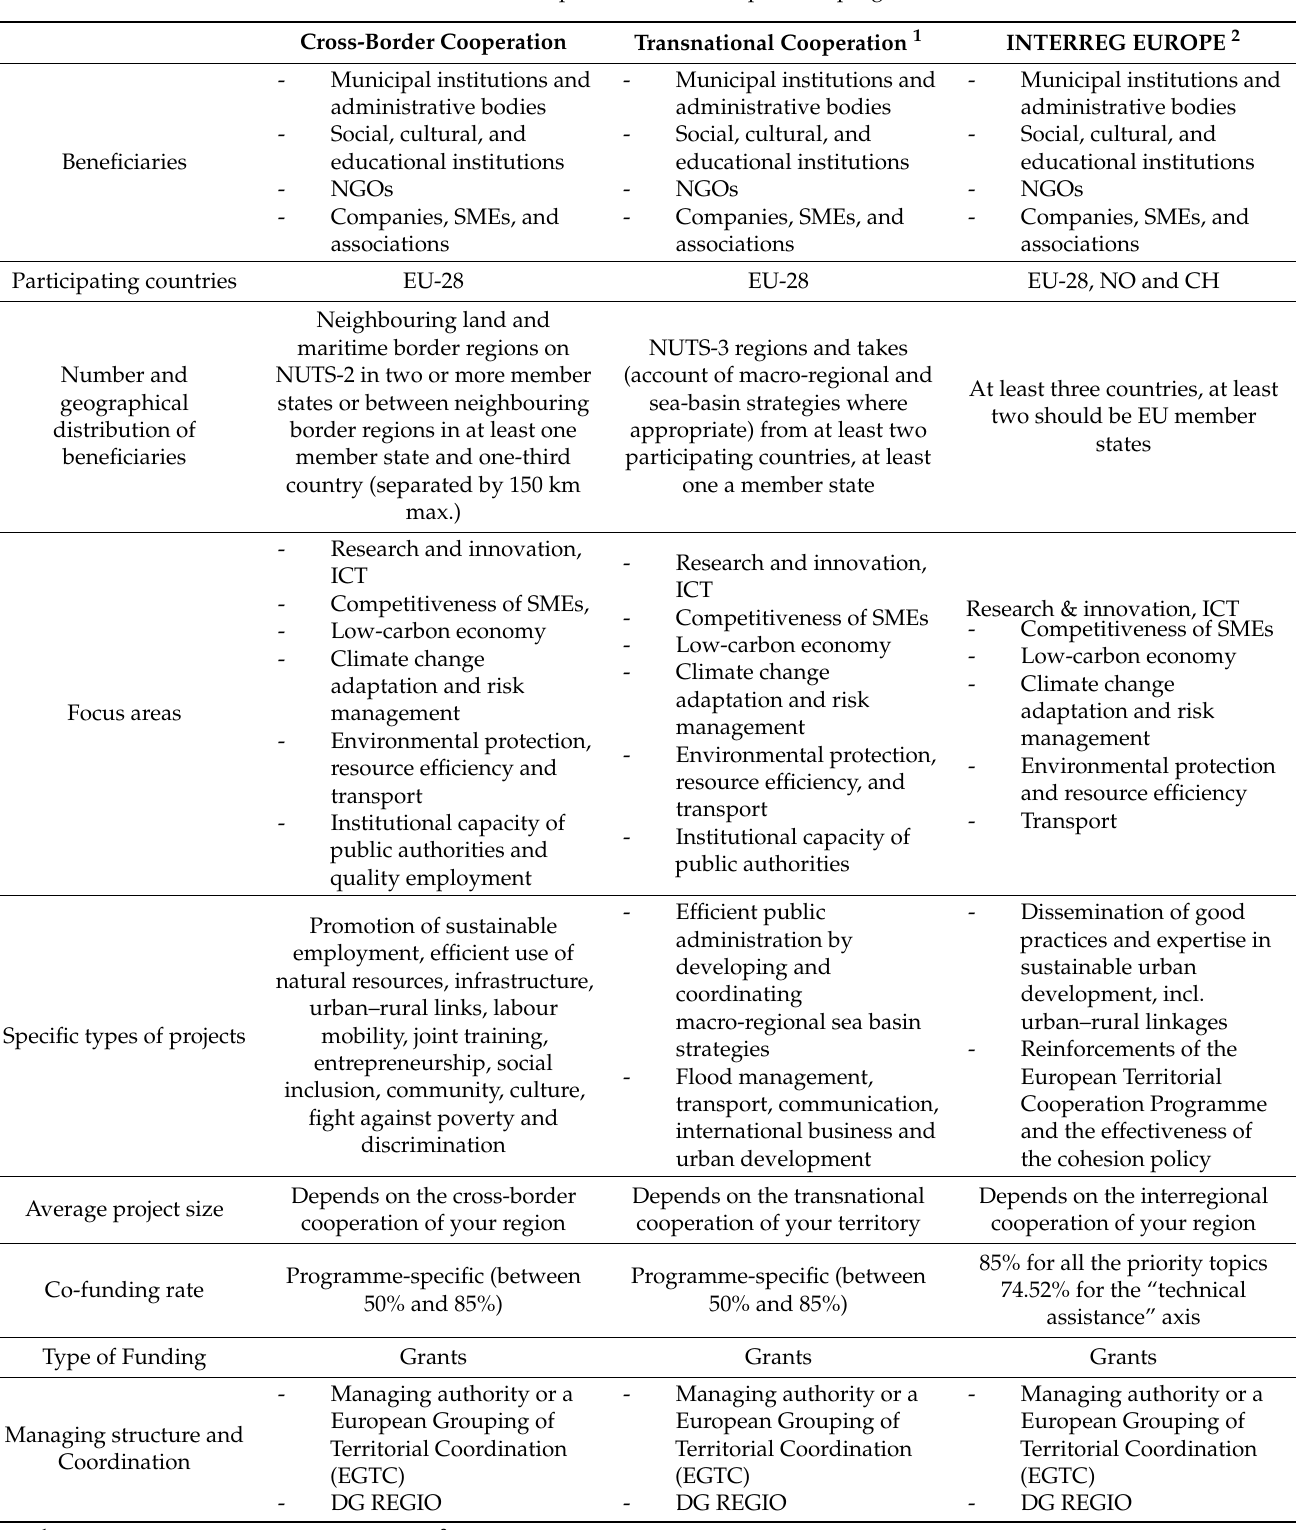
Table A3. Focus on European territorial cooperation